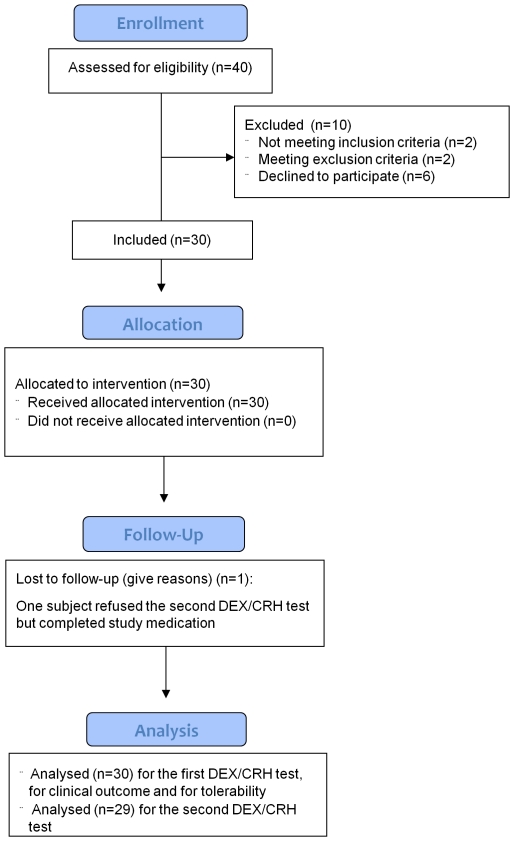
CONSORT 2010 Flow Diagram.